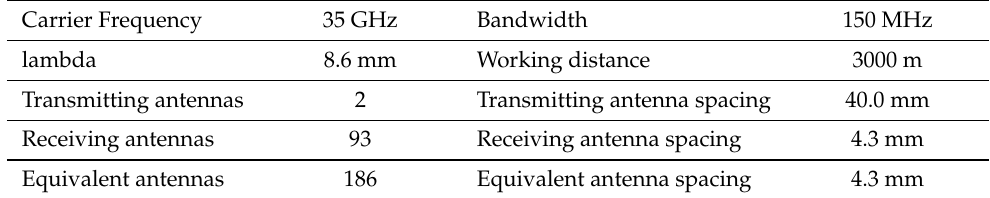
Table 1. Simulation MIMO radar